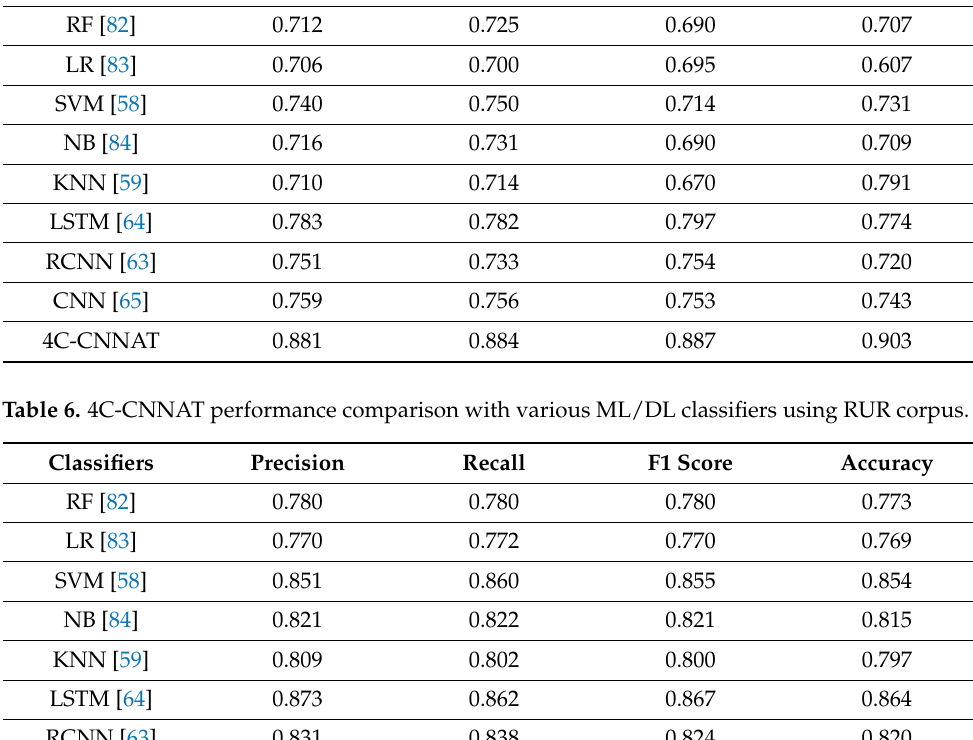
Table 5. 4C-CNNAT performance comparison with various ML/DL classifiers using RUDS corpus.